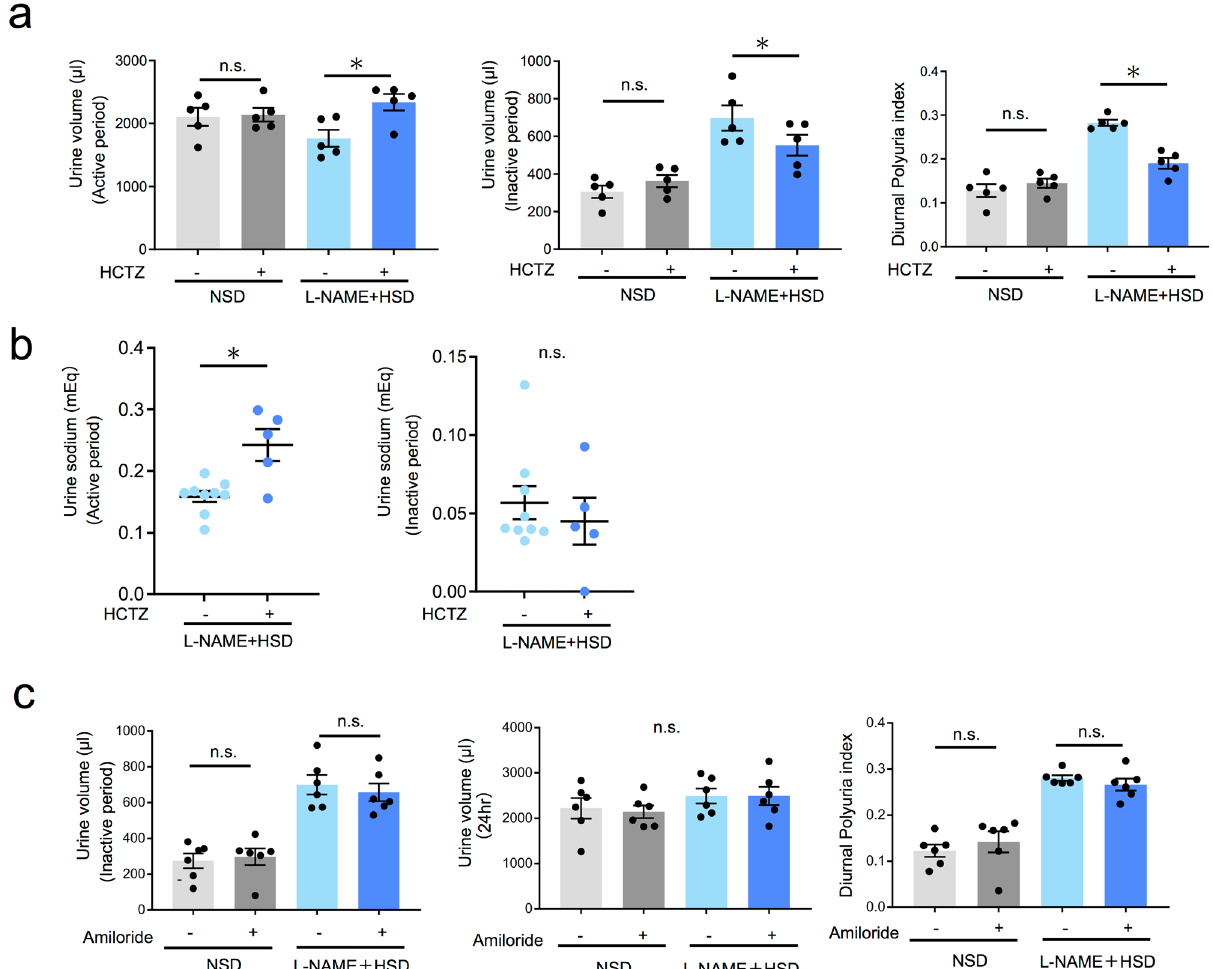
Fig. 4 Nocturnal polyuria is improved by treatment with an NCC inhibitor (HCTZ), but not by ENaC inhibitor treatment (amiloride). a Active period urine volume and inactive period urine volume and DPi in NSD and L -NAME + HSD groups after HCTZ administration ( n = 5 mice per group). Statistical analysis was performed using the two-tailed Student ’ s t -test. b Urinary sodium excretion per day during active (left) and inactive (right) periods (HCTZ-: n = 9, HCTZ + : n = 5 mice per group). Statistical analysis was performed using two-way ANOVA or the two-tailed Student ’ s t -test. * p < 0.05. c Inactive period urine volume and 24-h urine volume and DPi in NSD and L -NAME + HSD groups after amiloride administration. Data are expressed as the mean ± SEM (amiloride-: n = 6, amiloride + : n = 5). Statistical analysis was performed using the two-tailed Student ’ s t -test. All data are expressed as the mean ± SEM, * p <